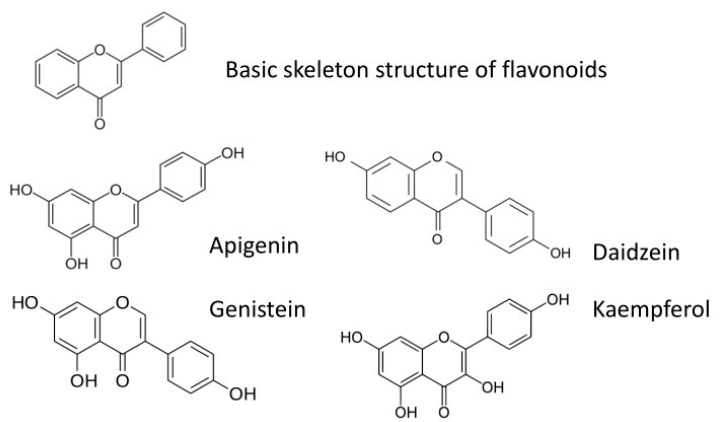
Figure 1. Basic skeleton structure of flavonoids and structures of flavonoids applied in the present study: apigenin, daidzein, genistein, and kaempferol. study: apigenin, daidzein, genistein, and